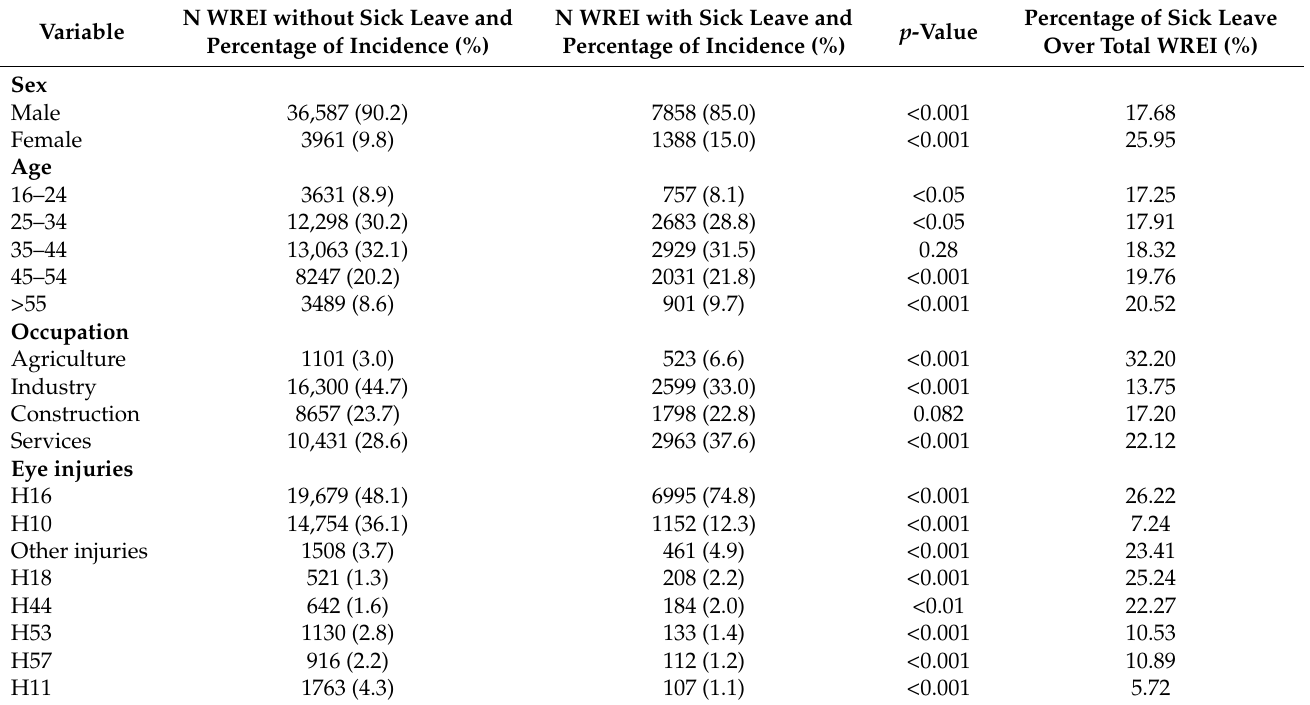
Table 2. Statistical relationship between WREI with and without sick leave for each variable and the total percentage of sick leave over total